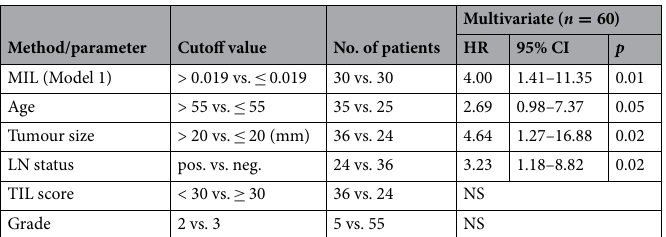
Method/parameter